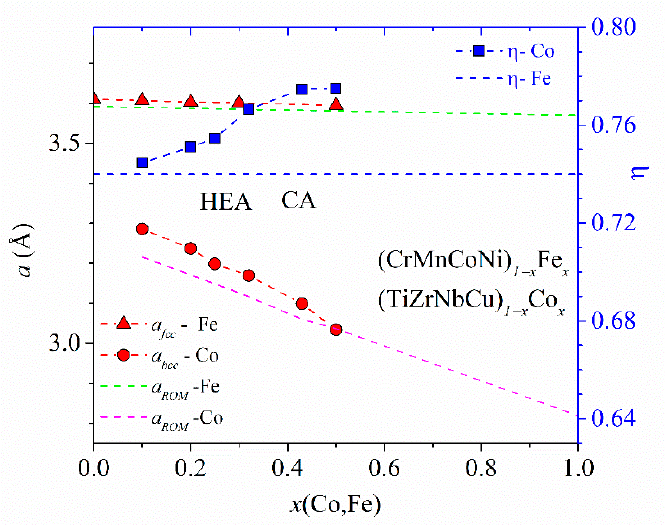
Figure 10. Lattice parameters a and the corresponding atomic packing fractions η a of (CrM- nCoNi) 1 − x Fe x and (TiZrNbNi) 1 − x Co x alloys vs. x . Green and magenta dashed lines denote variations of a calculated by using the rule of